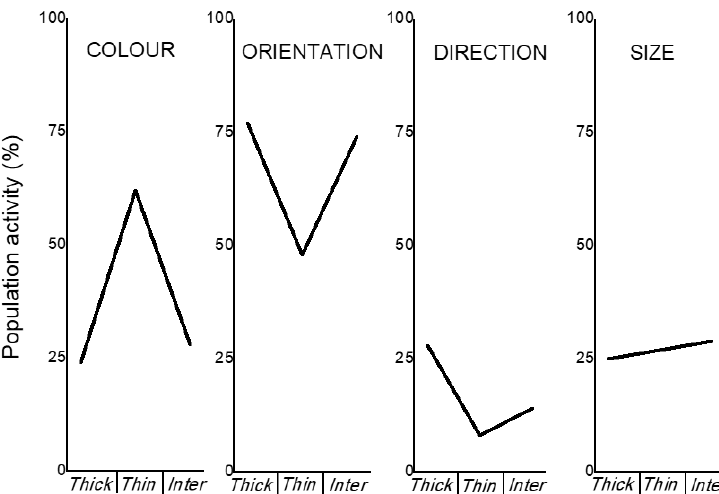
Figure 2. Relative population activities of neurons belonging to the thick stripes, thin stripes, and inter-stripes of the macaque monkey area V2 for color, orientation, direction of motion, and size [26]. A fuzzy set, proposed for the first time by the engineer Lotfi Zadeh in 1965 [29], is different from a classical Boolean set, as it breaks the Law of Excluded Middle. The Law of Excluded Middle states that an element y belongs to either set S or to its complement,